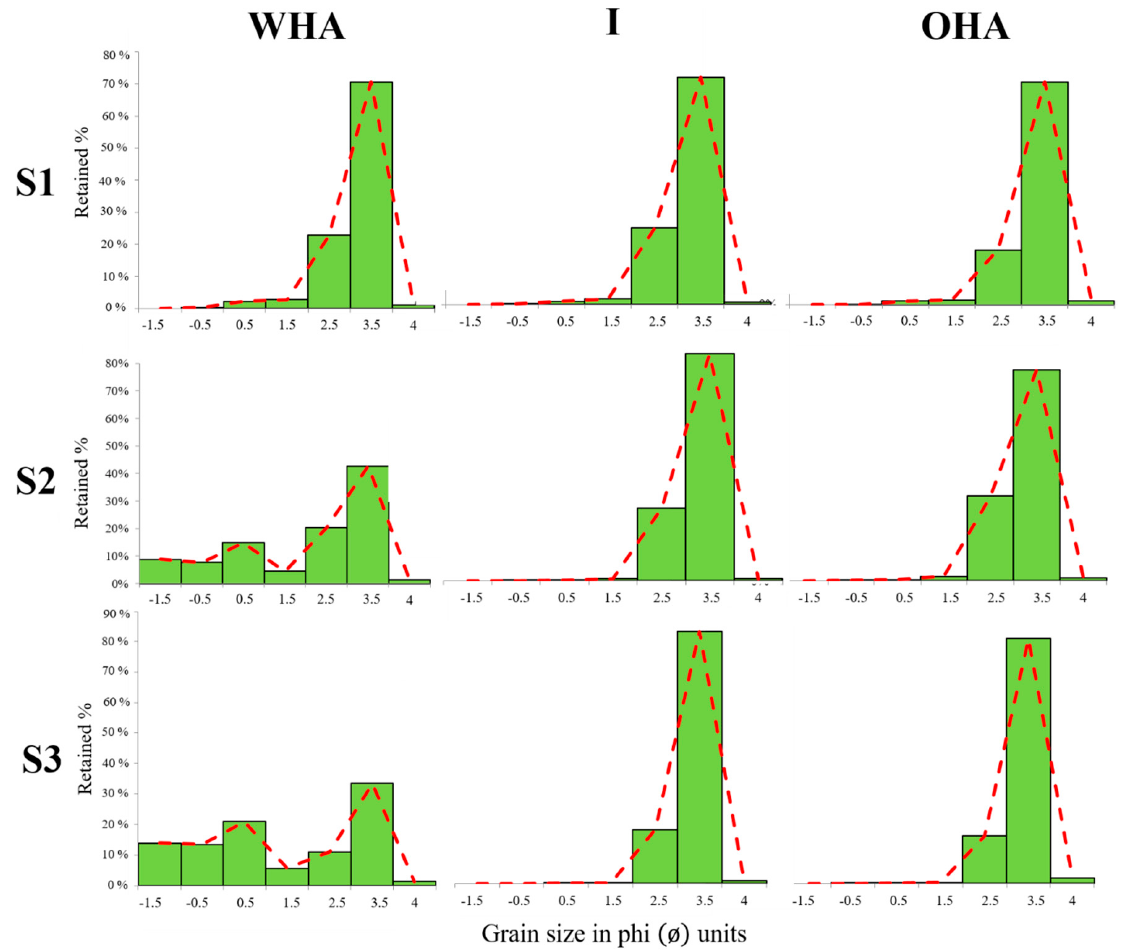
Figure 4. Histograms of the three areas at each study site. The x-axis represents the grain size in phi ( ø ) units, while the y-axis represents the percent of sediments retained in each class. The red dotted line represents the frequency polygon. The rows indicate the study sites and the columns the areas.